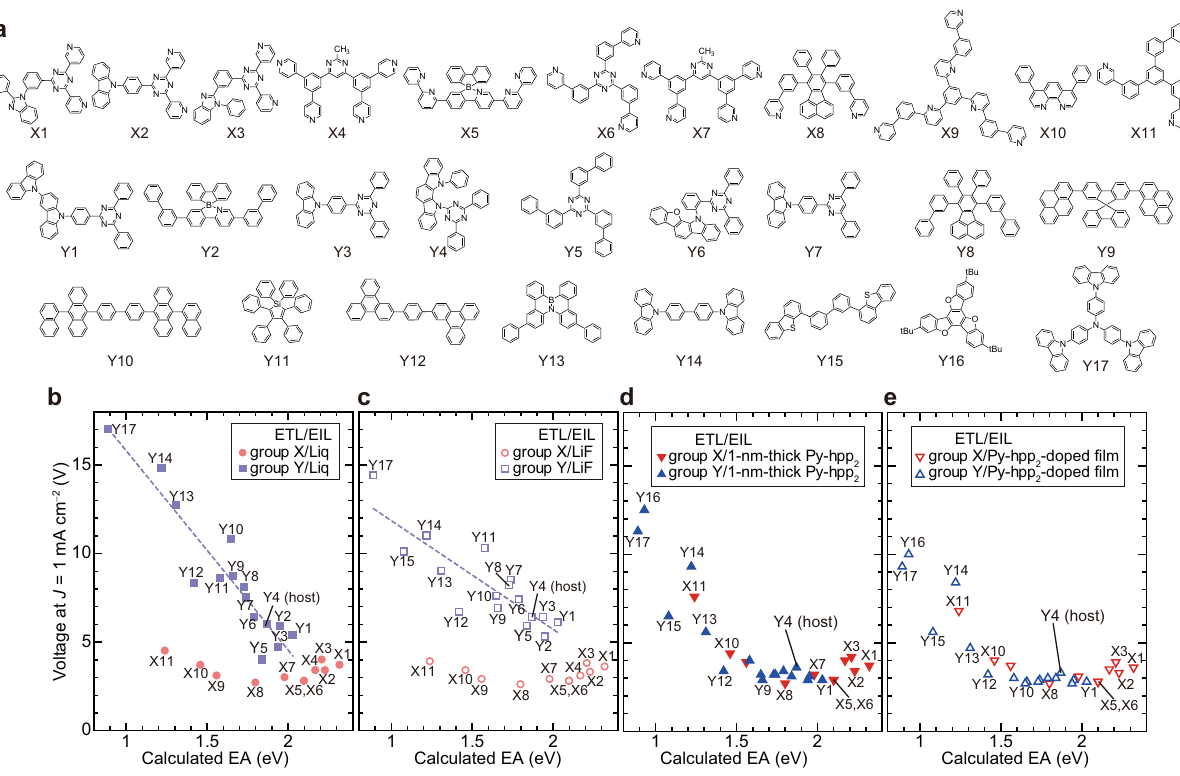
Fig. 2 Summary of OLED characteristics using 28 materials as ETL. a Chemical structure of materials used as ETL in green phosphorescent OLEDs. b – e Summary of correlation between calculated EA of materials used as ETL (horizontal axis) and operating voltage of OLEDs at current density ( J )